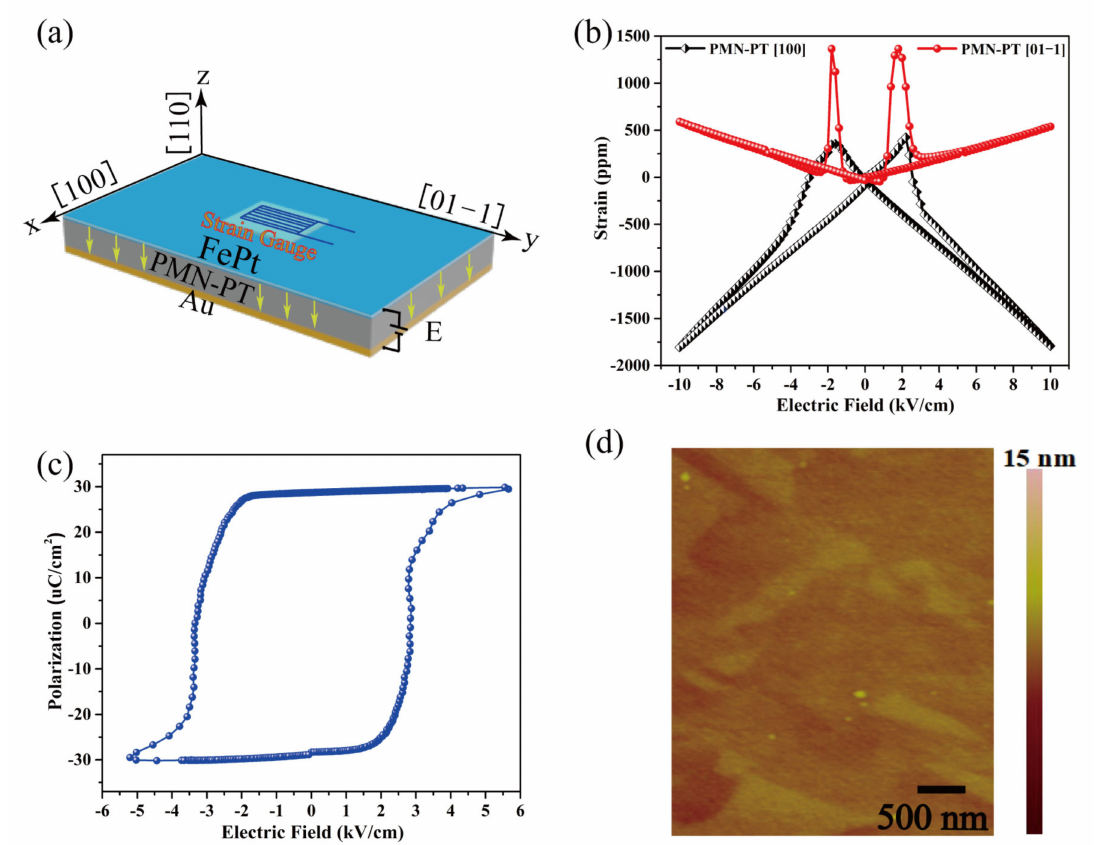
Figure 1. ( a ) Schematic diagram of strain measurement for the FePt/PMN-PT/Au under applied electric fields; ( b ) the electric field dependence of in-plane strain curves along the [100] and [01 − 1] directions, respectively; ( c ) the polarization hysteresis loop of the FePt/PMN-PT/Au at room temperature; ( d ) the surface morphology image of the FePt film with an area of 2 × 2 um 2